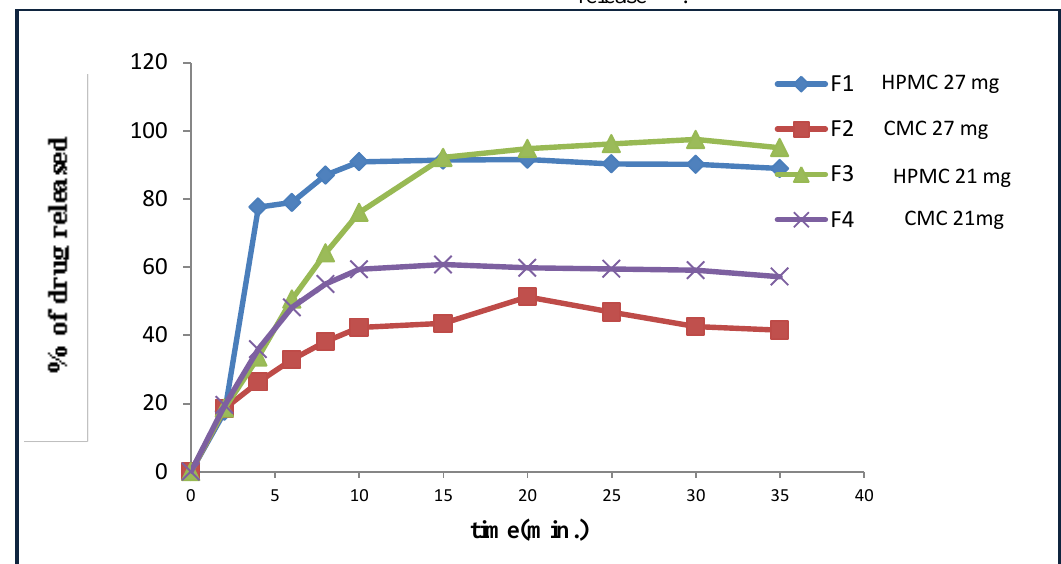
Figure4: Effect of polymer type and concentration on the release profile of Flurbiprofen in F1, F2, F3, and F4 phosphate buffer pH 6.8 and 37